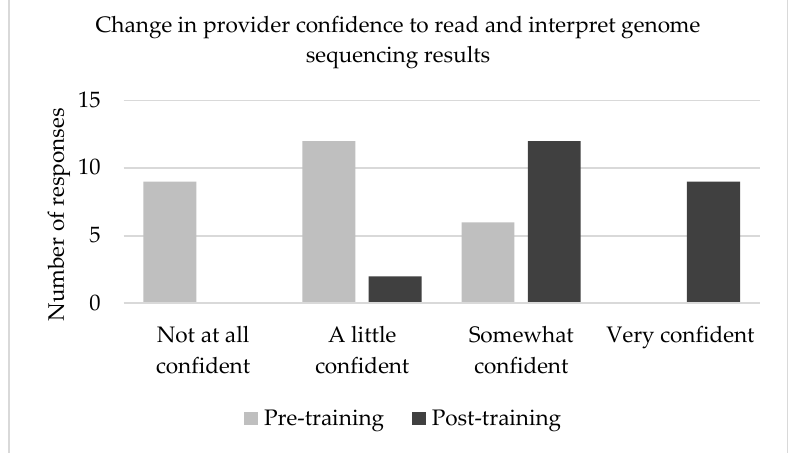
Figure 2. Comparison of self-reported provider confidence before and after participating in SouthSeq training about ability to read and interpret genome sequencing results.